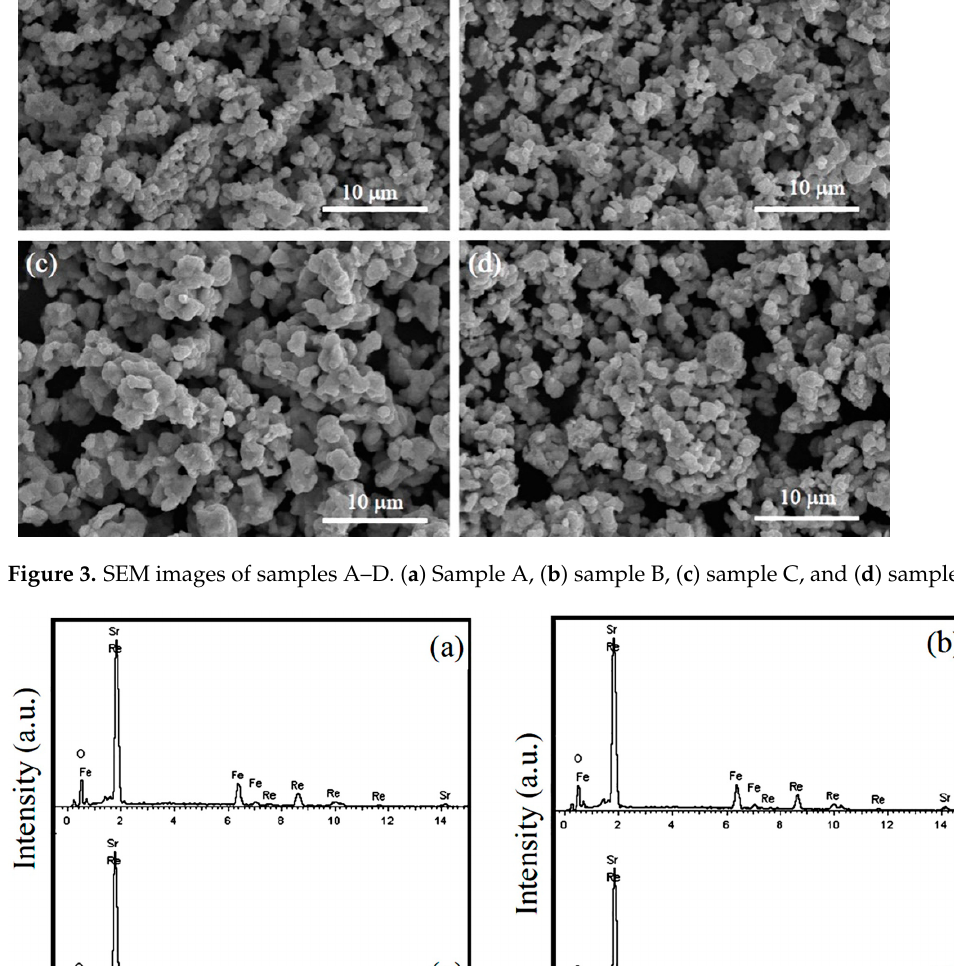
Figure 4. EDS spectra collected in a mapping mode for samples A–D. ( a ) sample A, ( b ) sample B, ( c ) sample C, and ( d ) sample D.